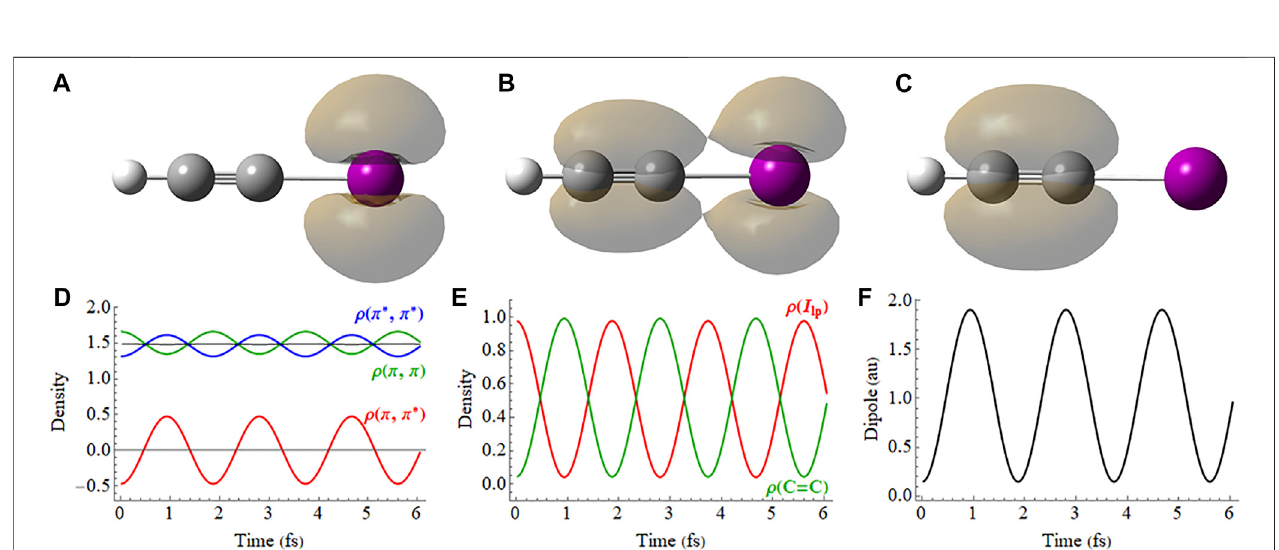
(cid:2) π − 1 + ) cation and (D) the A ( x ) cation.